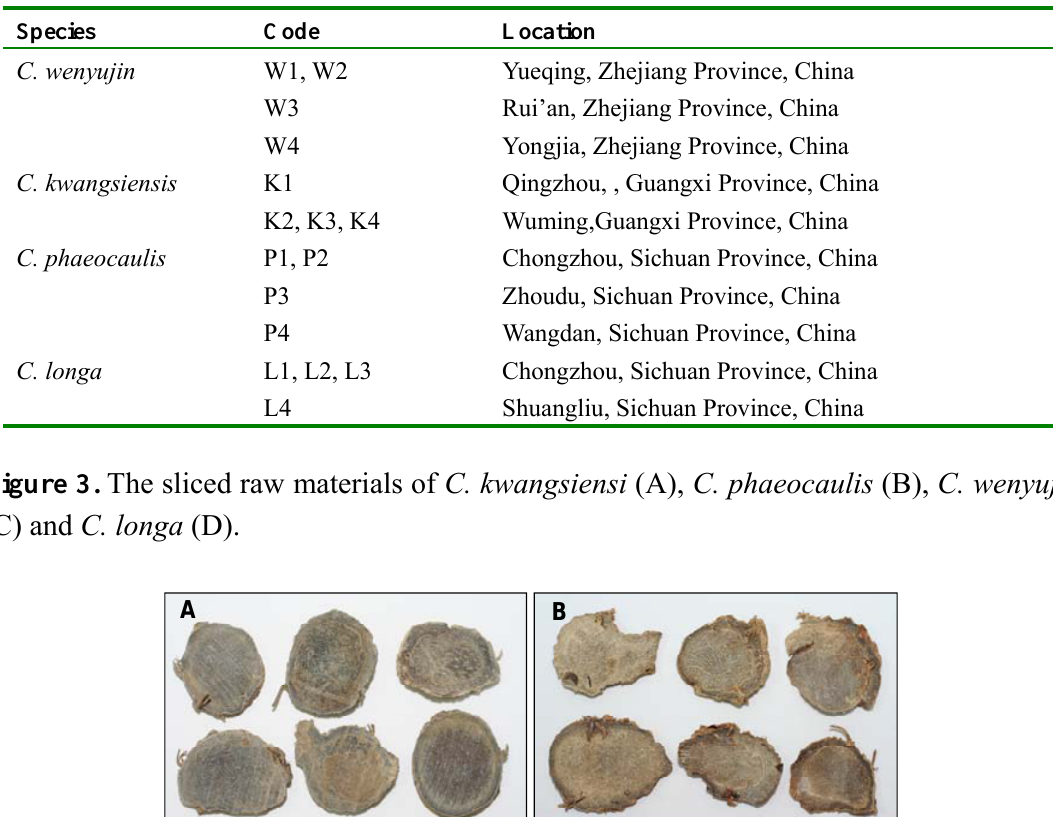
Table 3. Investigated rhizomes of four species of Curcuma.